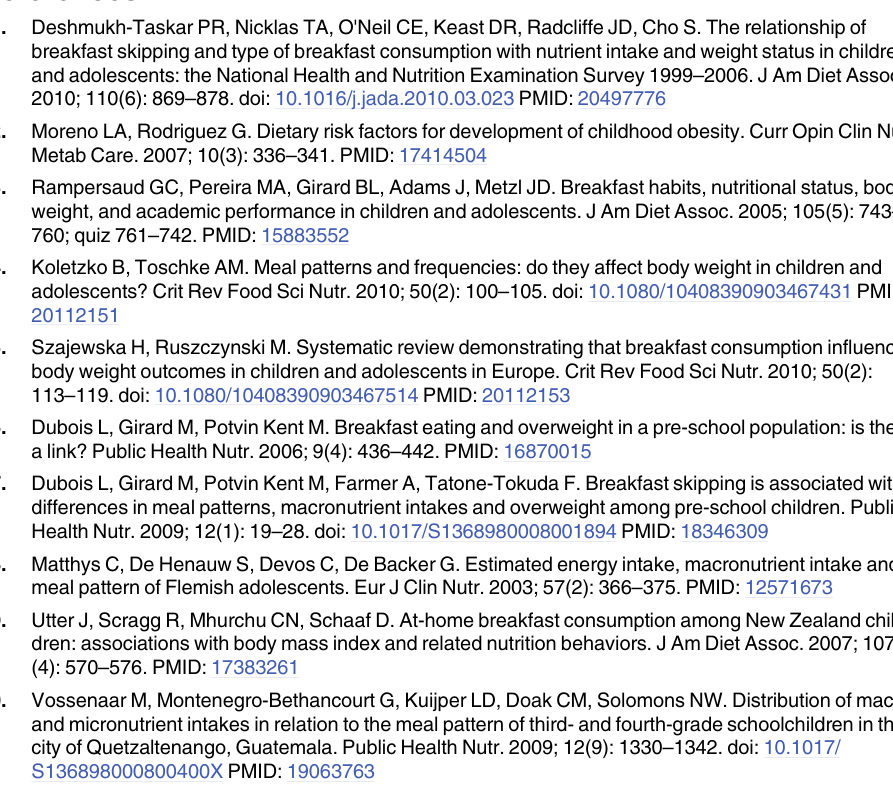
S2 Table. Number of meals consumed in the total population and according to family socioeconomic position and ethnic background (n = 4500). S3 Table. Associations of family socioeconomic position and ethnic background with num- ber of meals consumed (n =